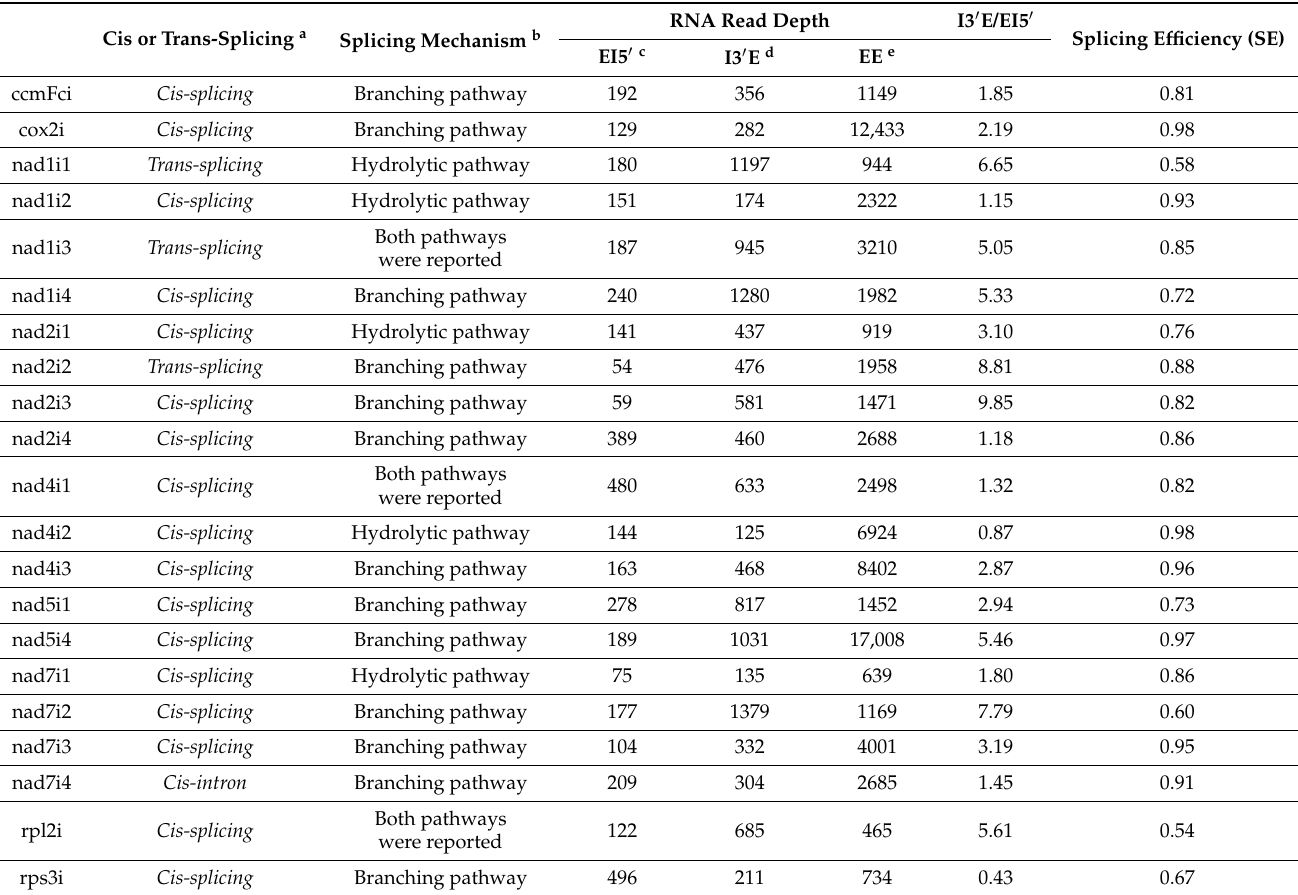
Table 1. Splicing efficiency of introns in the Arabidopsis mtDNA based on the combined RNAseq data sets of the three biological